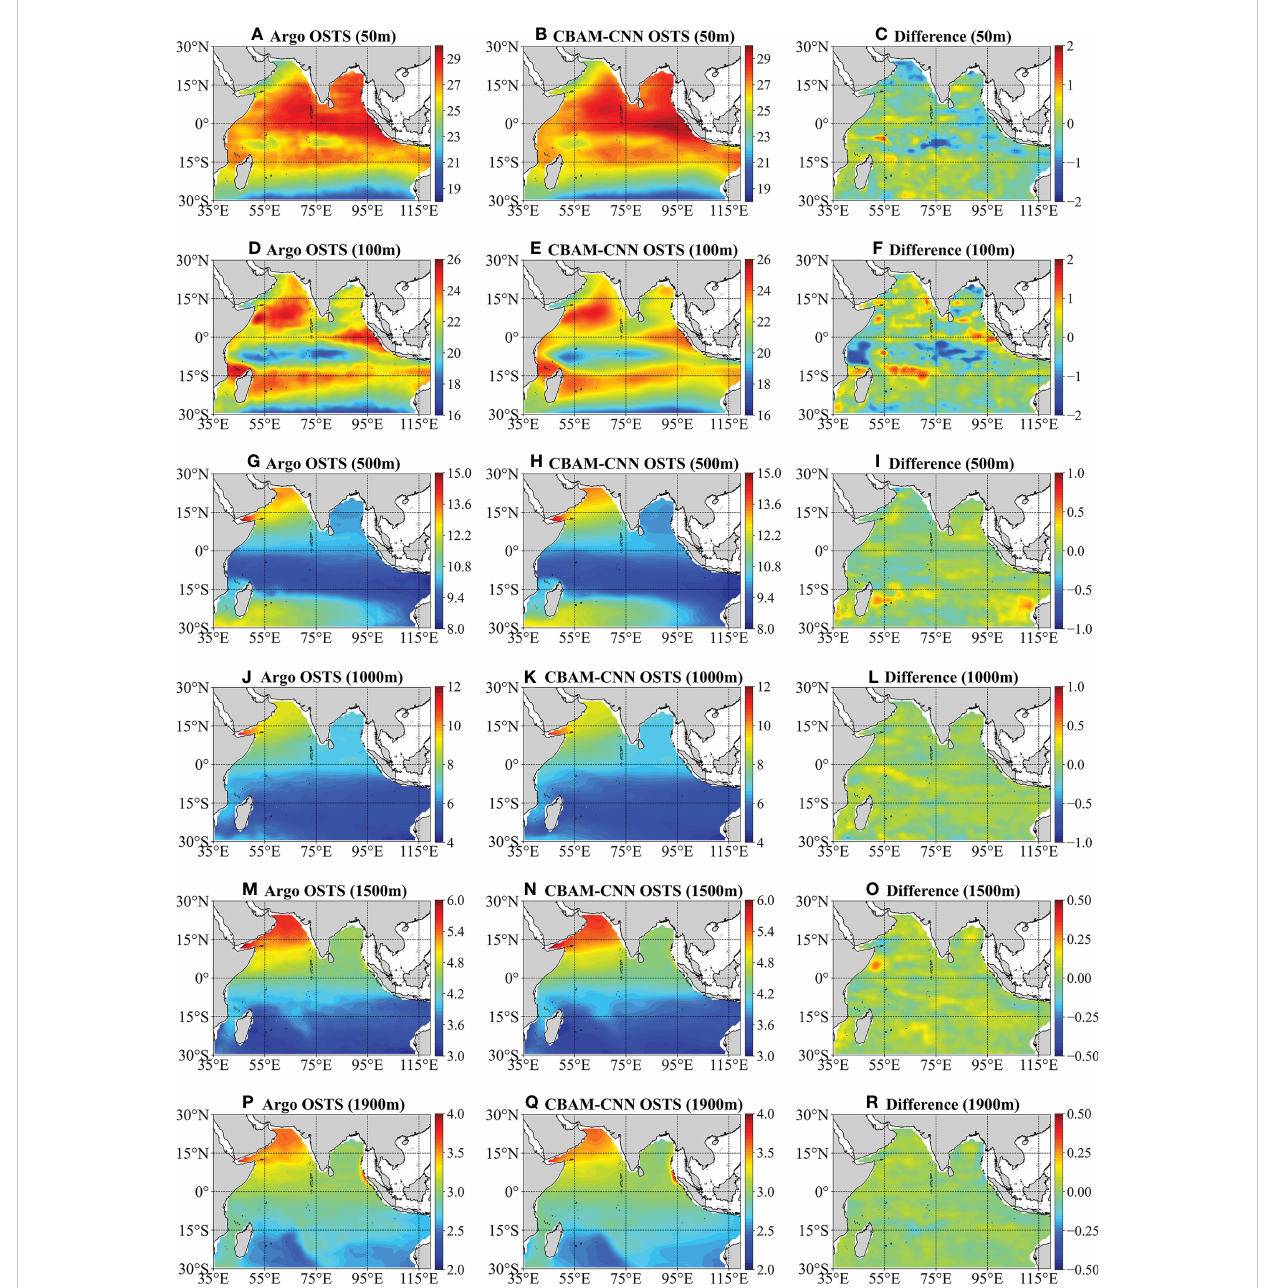
FIGURE 6 Annual average OSTS from Argo observation (left panel) and CBAM-CNN estimation (middle panel) and their differences (Argo minus CBAM-CNN, right panel) at different depths (50 m, 100 m, 500 m, 1000 m, 1500 m, 1900 m) in